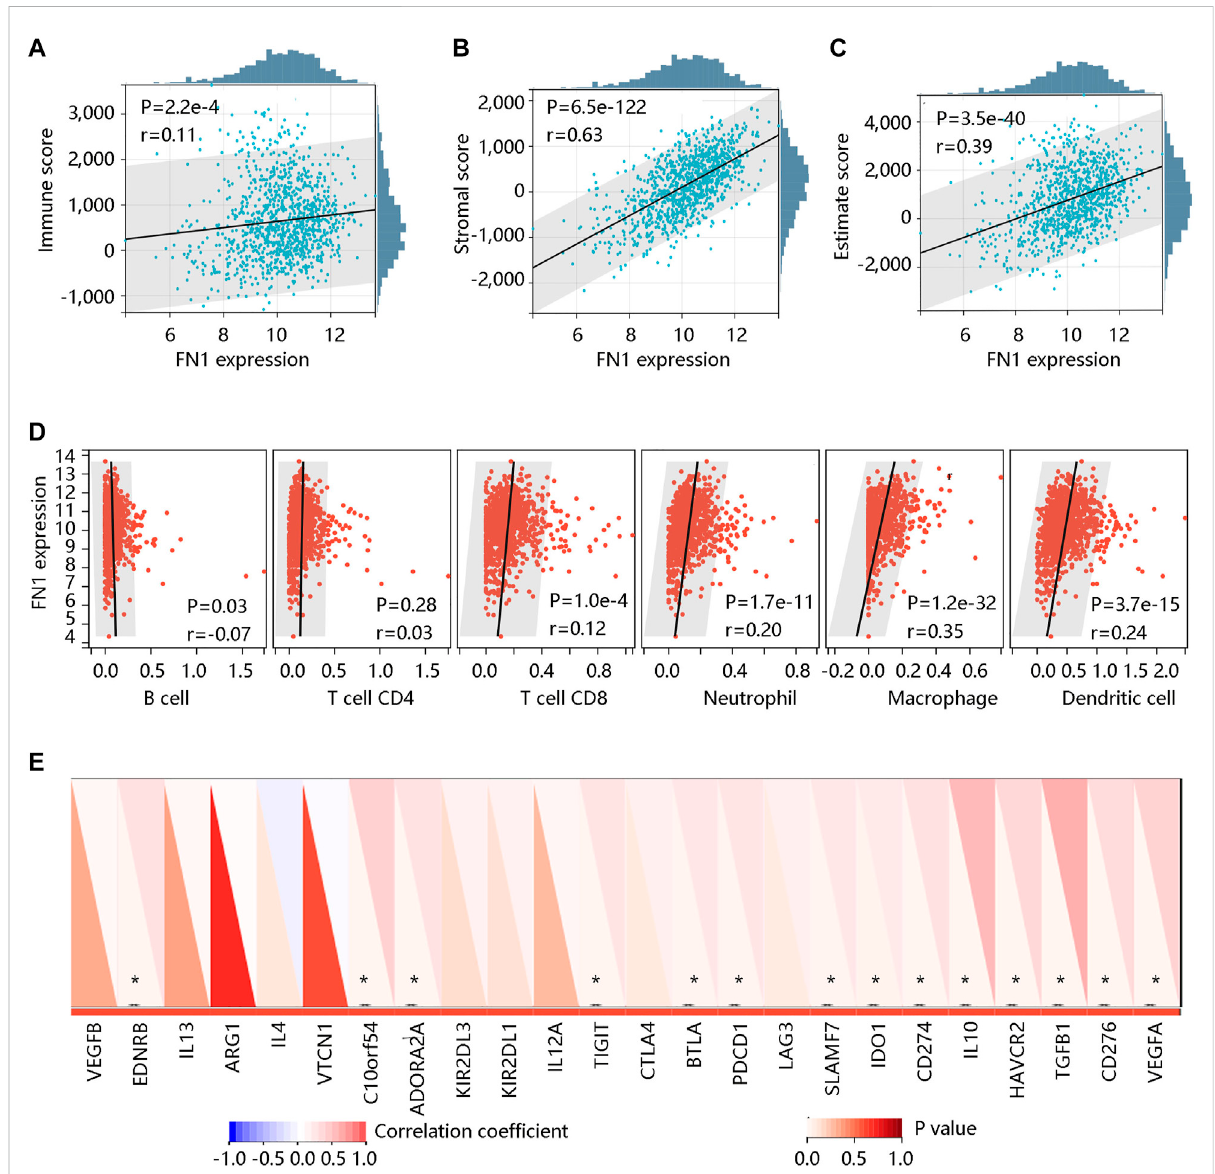
FIGURE 9 The correlation of FN1 expression with immune cell in fi ltration in breastcancer.The signi fi cantly positive association of FN1 expression with (A) Immune score, (B) Stromal score, and (C) Estimate score using the ESTIMATE algorithm. (D) The association of FN1 expression with immune cell in fi ltration via the TIMER algorithm. (E) FN1 expression was signi fi cantly related to 14 immune checkpoint inhibitors. * p <